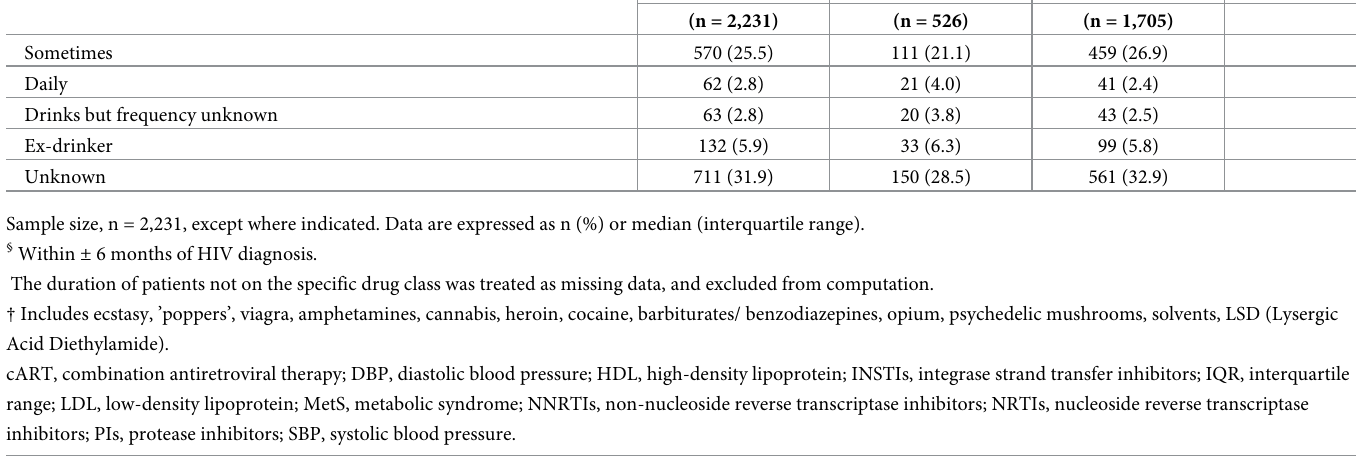
The median duration of HIV infection was 82 months (6.8 years). More than two-thirds (64.9%) did not have prior AIDS diagnosis, and 46.9% had CD4 � 200 cells/mm 3 at the time of HIV diagnosis. About 35.5% of the individuals did not have HIV viral load measurements within 6 months of HIV diagnosis, while among 1,439 with known HIV viral load, 1,369 (95.1%) were not virologically suppressed ( > 200 copies/mL). The majority had been tested negative for HBV (87.9%) and HCV (91.7%). The median duration of exposure to cART was 68 months (5.7 years) (Table 1). All the PLHIV had been exposed to nucleoside reverse transcriptase inhibitors (NRTIs) as the first line of treatment. 28.6% had a history of exposure to PIs and 12.8% to integrase strand transfer inhibitors (INSTs). The most common combination of cART was two NRTIs plus one non- nucleoside reverse-transcriptase inhibitor (NNRTI), followed by two NRTIs plus one PI (S1 Table). The most common antiretroviral agent by drug class was tenofovir from NRTIs, efavir- enz from NNRTs, ritonavir from PIs and raltegravir from INSTIs. The most common metabolic abnormality was HDL hypocholesterolemia (60.2%) followed by hypertriglyceridemia (45.5%) (Table 2). Of all the 2,231 individuals, 68.8% had at least one metabolic abnormality, and of these 1,536 individuals, 25.7% had one component, 40.0% had two components, 23.2% had three components, 10.0% had four components and 1.0% had all five MetS components. The overall prevalence of MetS was 23.6% (95% confidence interval